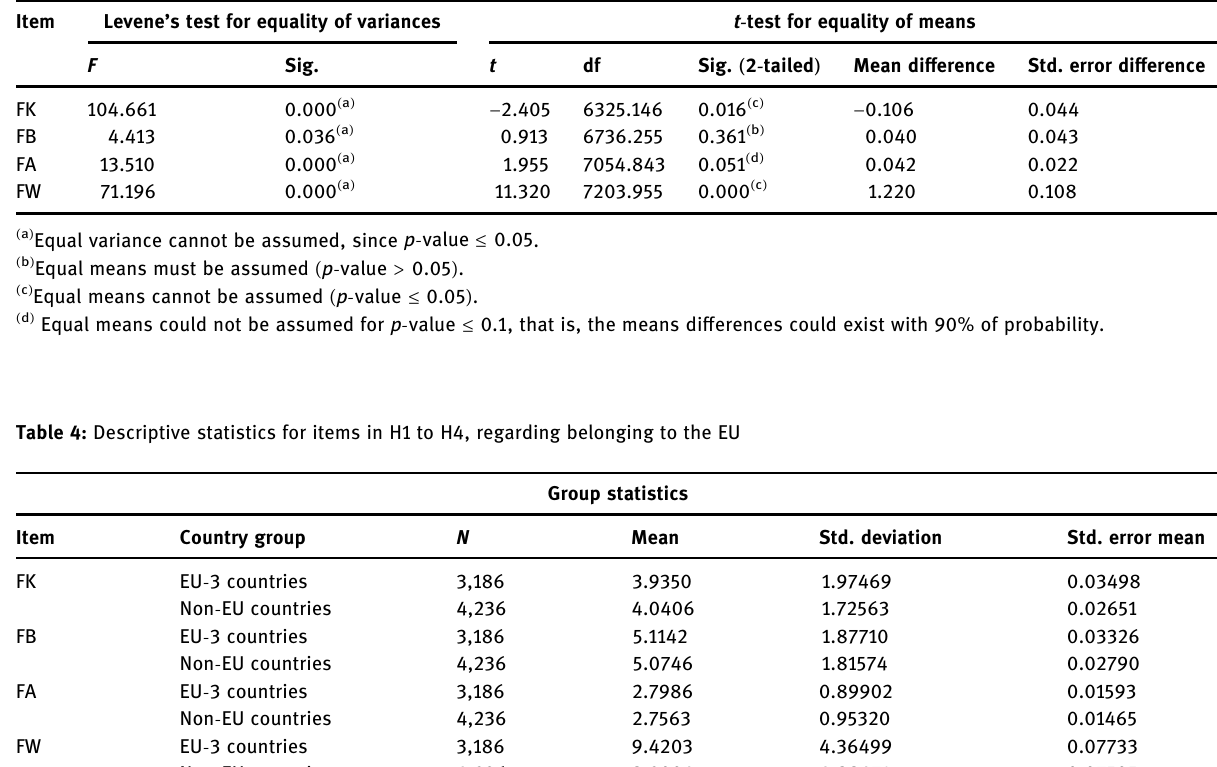
are lower in the non - EU countries compared to the EU - 3